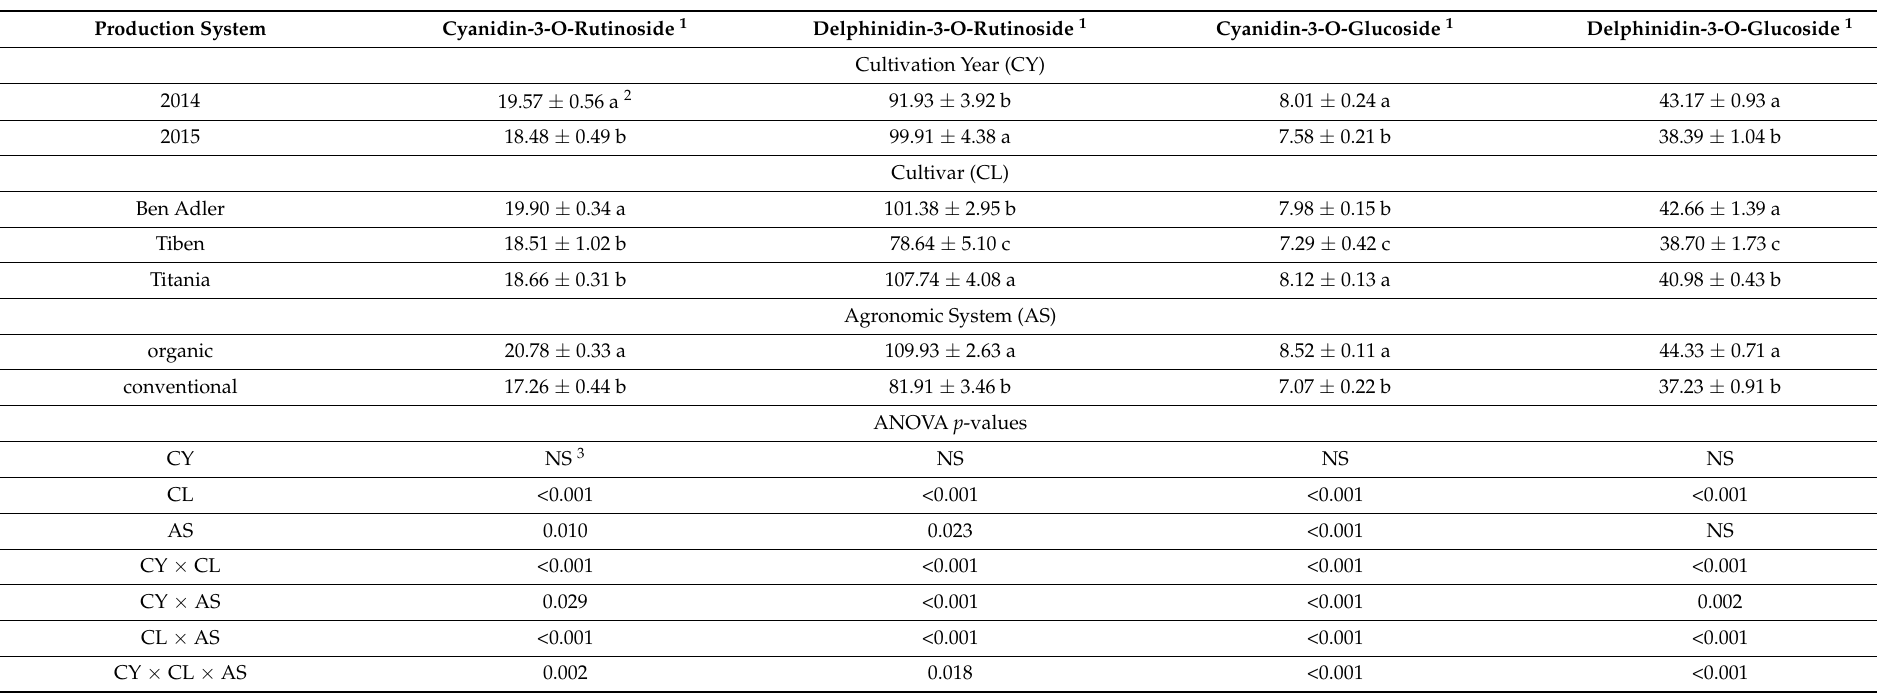
Table 4. The main effects of, and between, cultivation year, cultivar and agronomic system on the content of individual anthocyanins in blackcurrant fruits (in mg 100 g